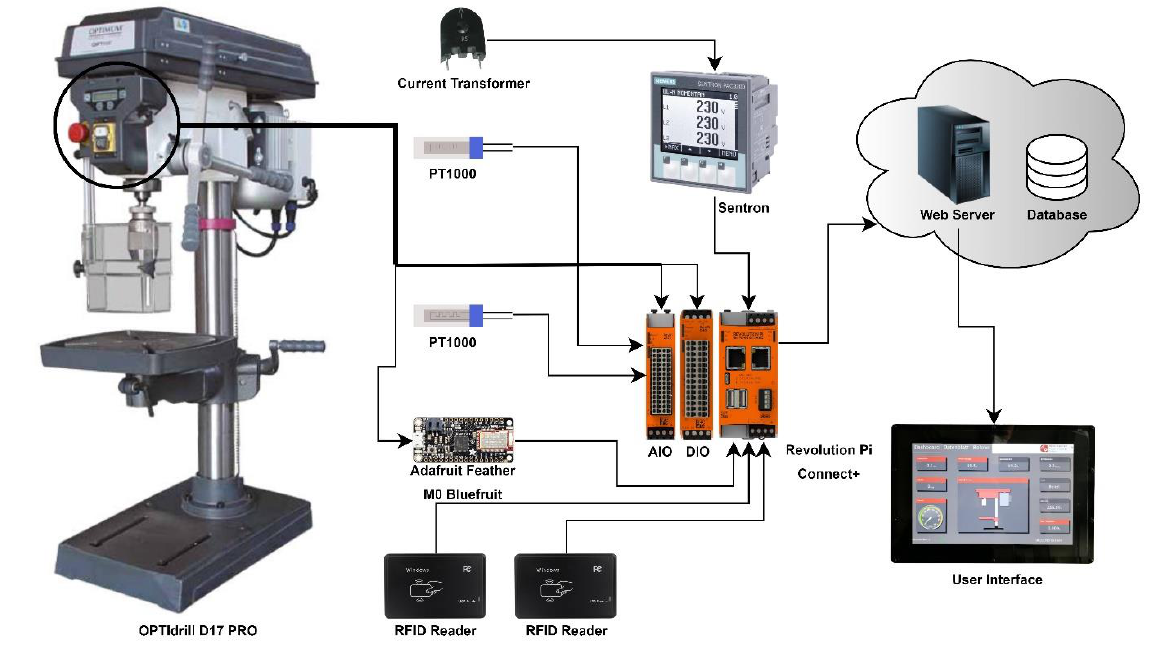
Figure 2. Retrofitted bench